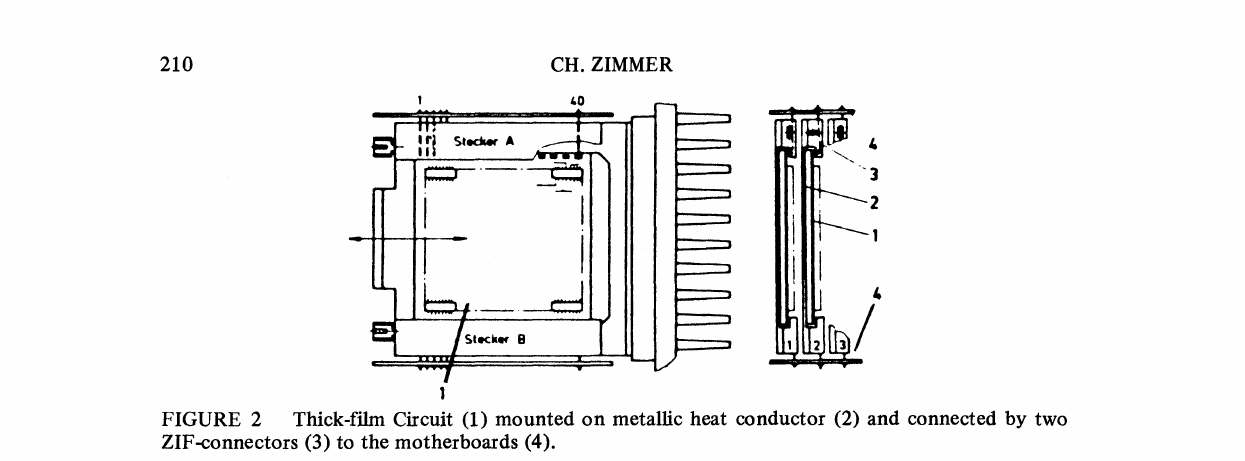
FIGURE 2 Thick-film Circuit (1) mounted on metallic heat conductor (2) and connected by two ZIF-connectors (3) to the motherboards